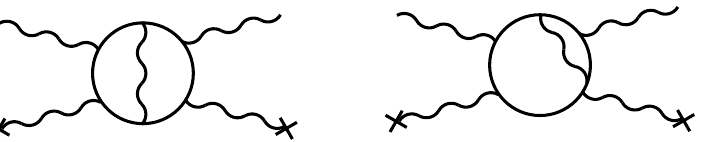
Figure 2. Example of two Feynman diagrams representing radiative corrections to vacuum magnetic birefringence due to the e + e −